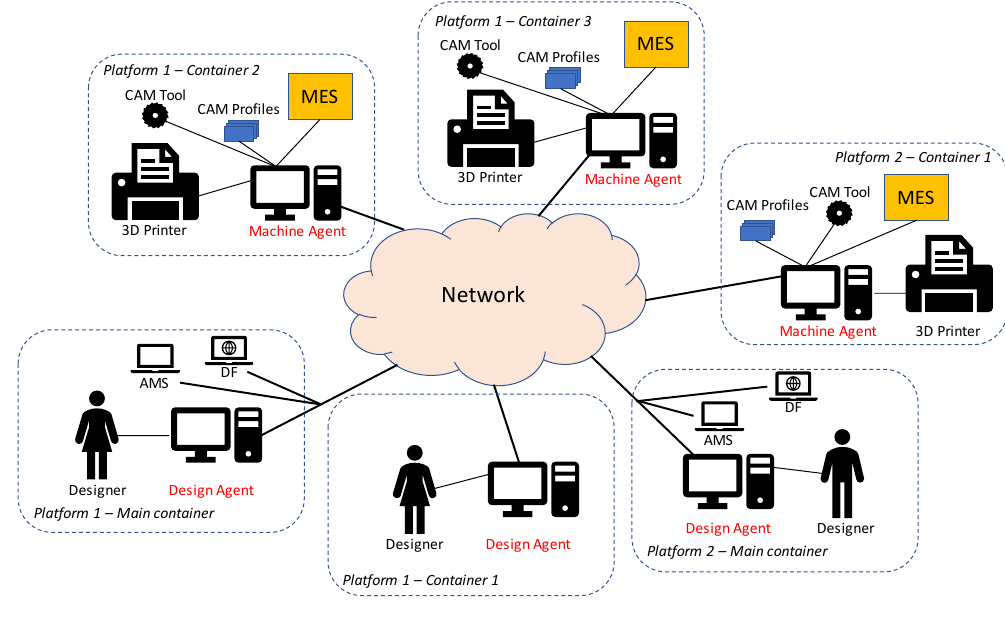
Figure 3. Agent-based platform.